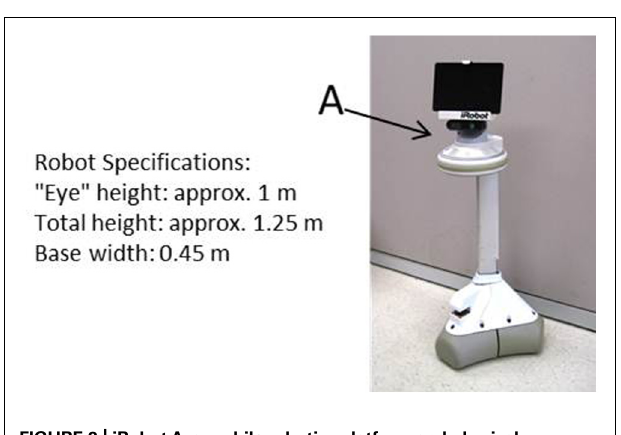
FIGURE 2 | iRobotAva mobile robotics platform and physical specifications. Primary robot sensors are denoted by